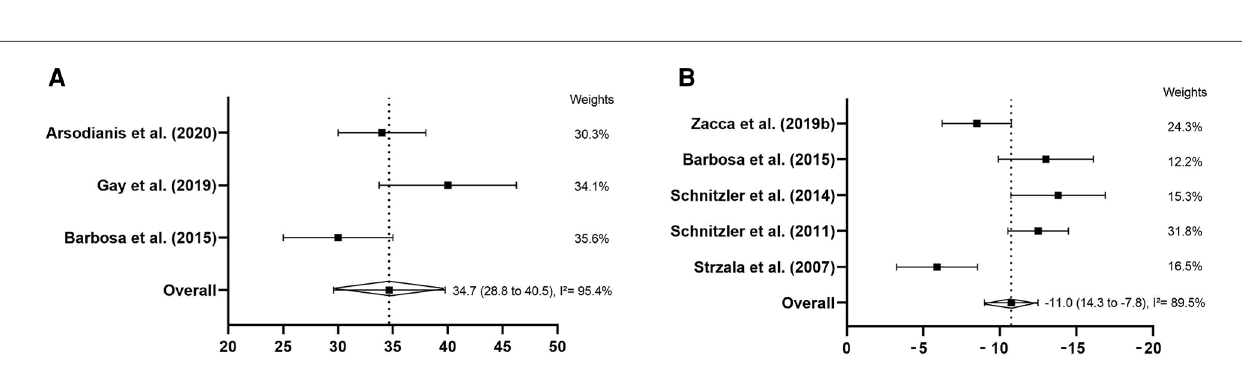
speed is the parameter that best represents a swimmer ’ s performance (46). The faster the swimmer is (and the more able to sustain high speed), the shorter the time to complete the desired distance,